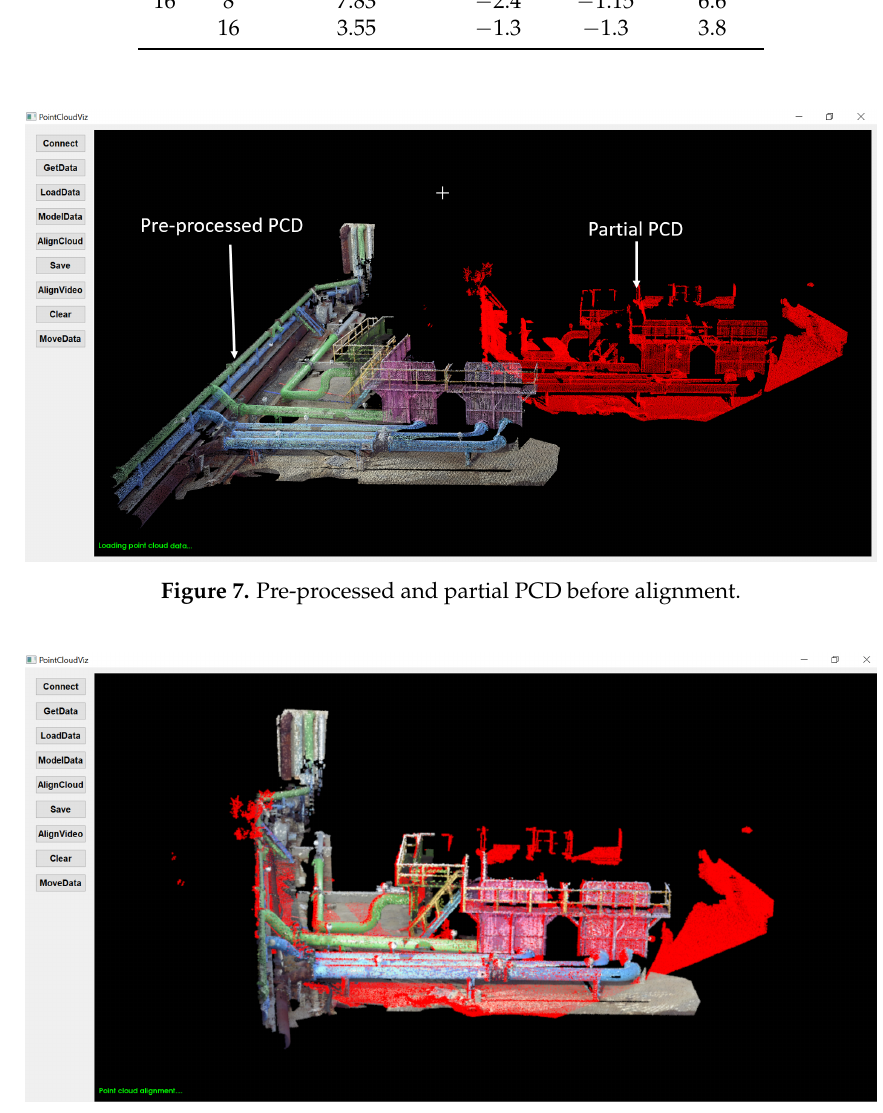
Figure 8. Pre-processed and partial PCD after